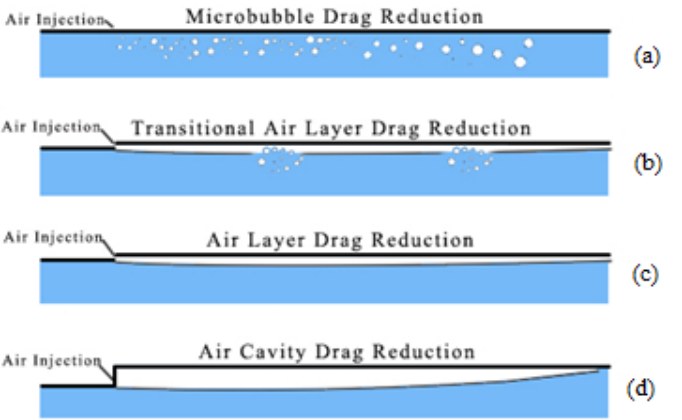
Figure 1. Various modes of air lubrication drag reduction. The modes can be listed as: ( a ) MBDR mode; ( b ) Tfansitional ALDR mode; ( c ) ALDR mode; ( d ) ACDR mode.